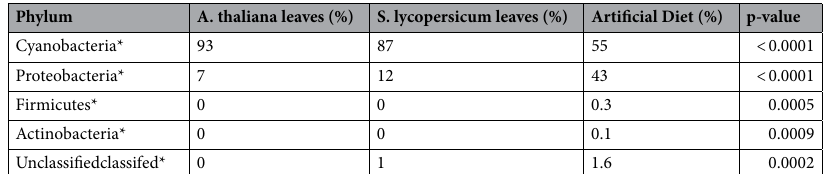
Table 1. Bacterial relative abundances from plant and artificial diets used to feed Trichoplusia ni populations. ANCOVA univariate test (P < 0.05). Bacterial relative abundance percentages were determined by comparing the numbers of ASVs classified at the phyla level to all other detected microbiota in each community. Asterisks indicate statistically significant differences between abundance values detected from all populations to p < 0.05.